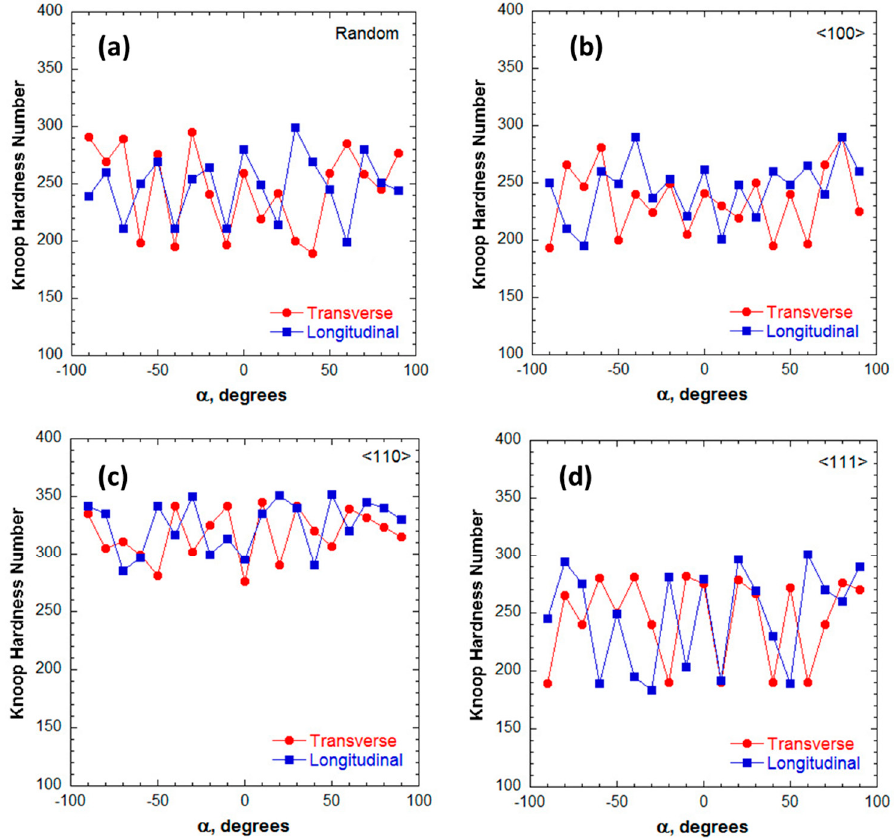
Figure 3. Variation of Knoop hardness (1 kgf) number with indenter orientation for transverse and longitudinal cross sections of the four processing conditions: ( a ) random, ( b ) < 100 > , ( c ) < 110 > and ( d ) < 111 > . The value of α is the angle of long diagonal from longitudinal (longitudinal cross section) and arbitrary transverse (transverse cross section) directions.